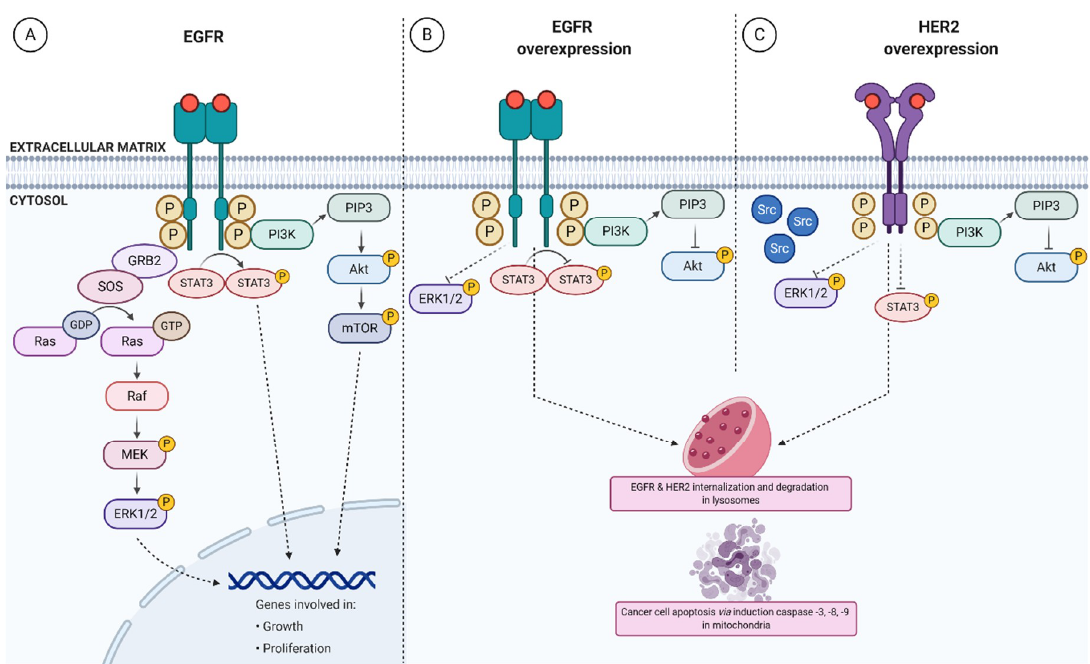
Figure 2. Prolidase-dependent EGFR- and HER2-downstream signaling. Prolidase binds to EGFR and HER2, evoking intracellular responses. ( A ) Under physiological conditions, direct binding of PEPD to EGF receptor results in the induction of pro-growth and pro-proliferation pathways such as phosphoinositide 3-kinase (PI3K)/protein kinase B (Akt)/mammalian target of rapamycin (mTOR), extracellular signal-regulated kinase (ERK)1/2, and signal transducer and activator of transcription 3 (STAT3). ( B ) Under overexpression of EGFR, prolidase silences Akt, ERK1/2, and STAT3 pathways followed by internalization and degradation of the receptor. ( C ) PEPD affects upregulated HER2 via dissociation of HER2-Src complex, inhibition of Akt, ERK1/2 and STAT3 pathways, and induction of apoptosis. Red dots indicate prolidase and circled ‘P’ presents phosphorylation event. HER2—epidermal growth factor receptor 2, EGFR—epidermal growth factor receptor. Created with BioRender.com.